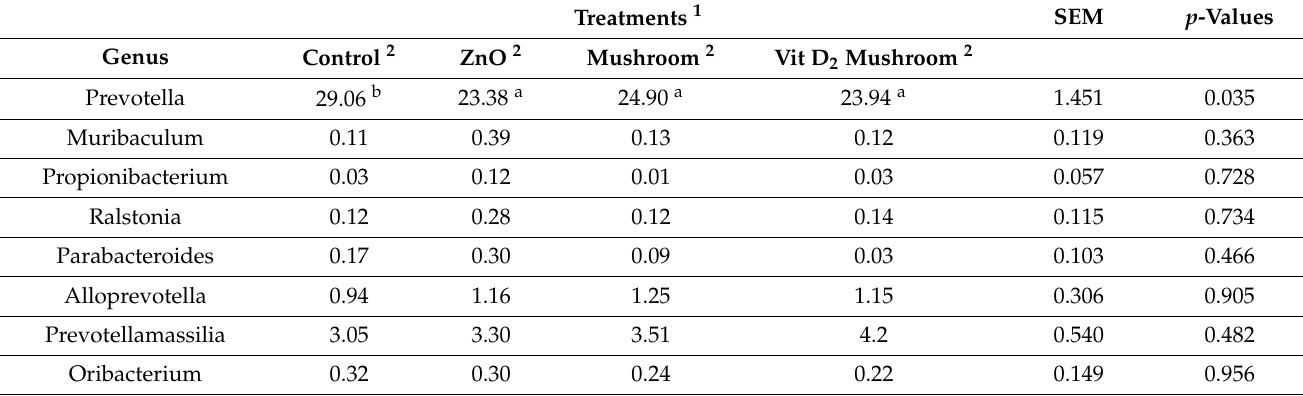
Table 8. The effect of dietary treatment on the % bacterial abundance at genus level (Least-square means with their standard